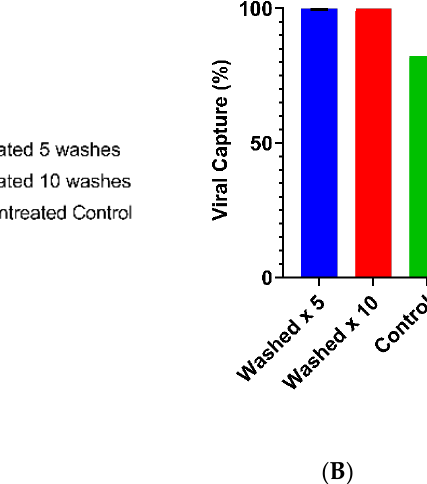
( D ) Figure 2. ( A ) Accumulated percentage reduction and ( B ) antiviral activity values of H1N1 and the ( C ) accumulated per-